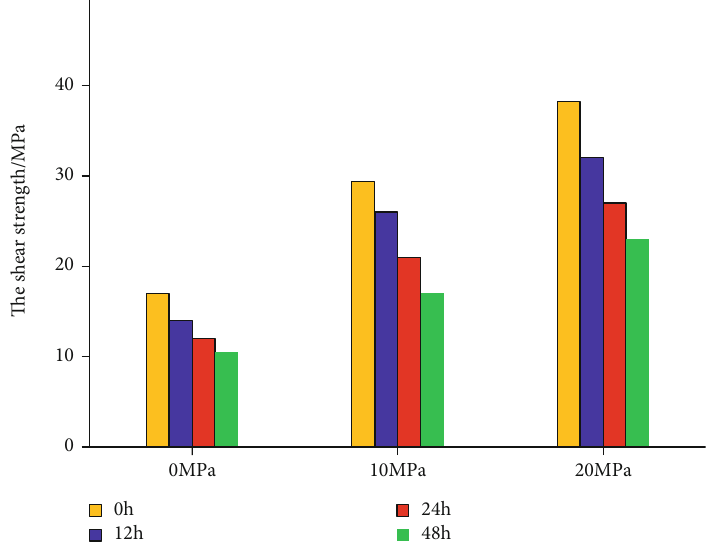
Figure 11: Strength of the bedding planes in the middle-deep transition shale after drilling fl uid